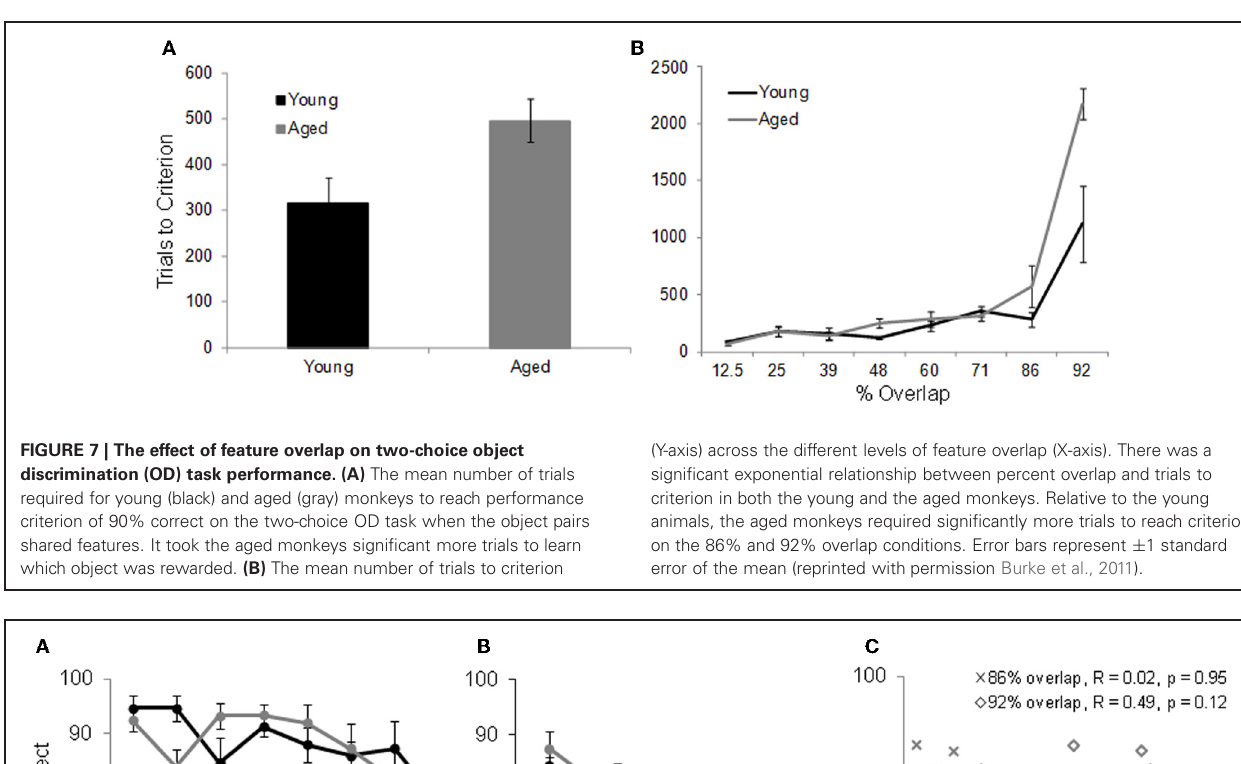
delay conditions (X-axis) shows that working memory was comparable between this population of young and aged monkeys. Error bars represent ± 1 standard error of the mean. (C) OD task performance (X-axis) versus DR task performance (Y-axis, 10s delay) shows that there was no significant relationship between working memory ability and a given monkey’s ability to learn difficult discrimination